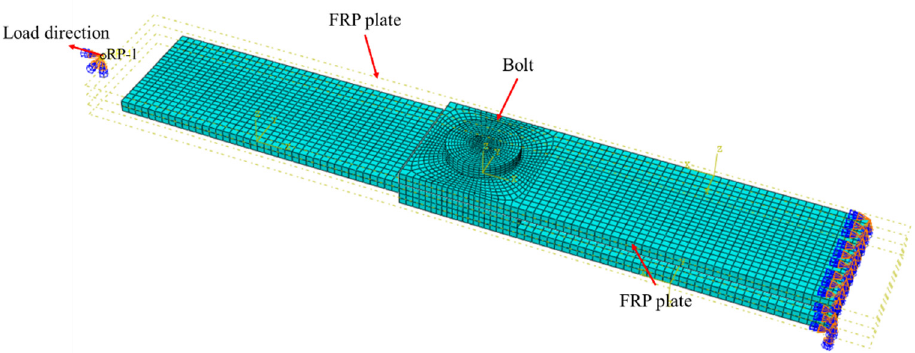
Figure 11. FE model of double-lap shear test of GFRP bolted joints .